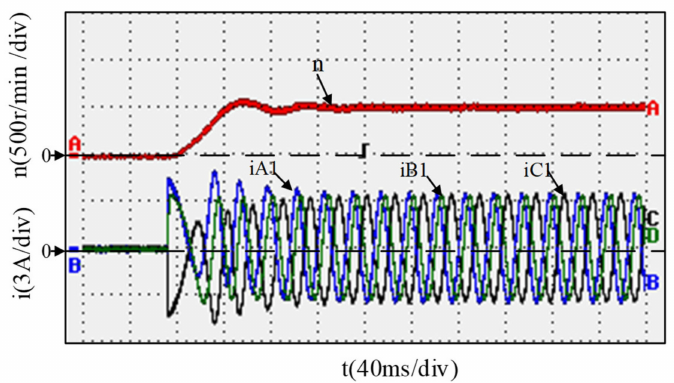
Figure 26. Waveforms of the speed and the current.